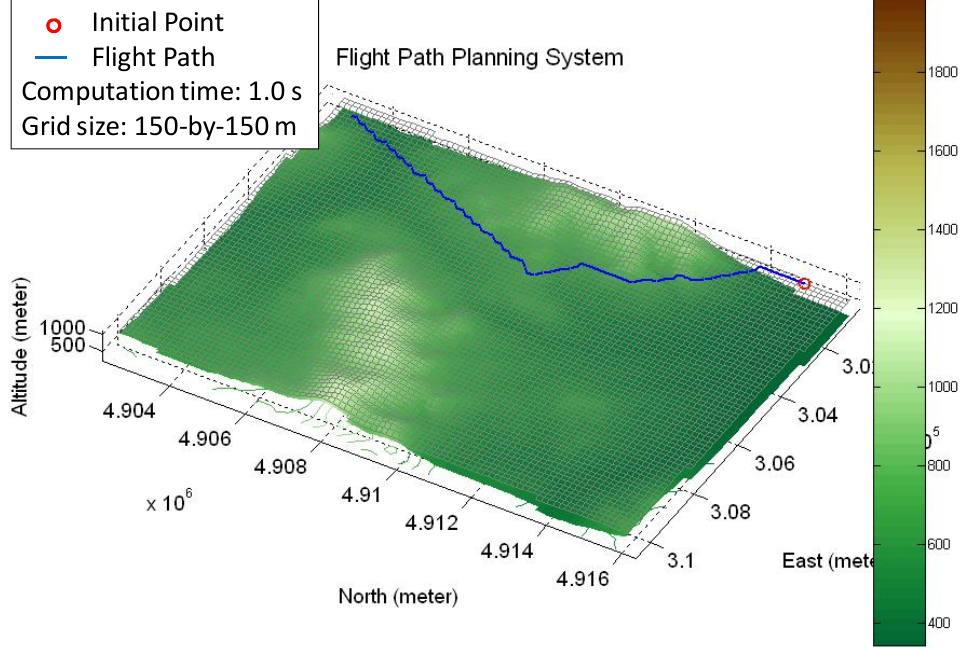
Figure 4. The resulting flight path by the developed